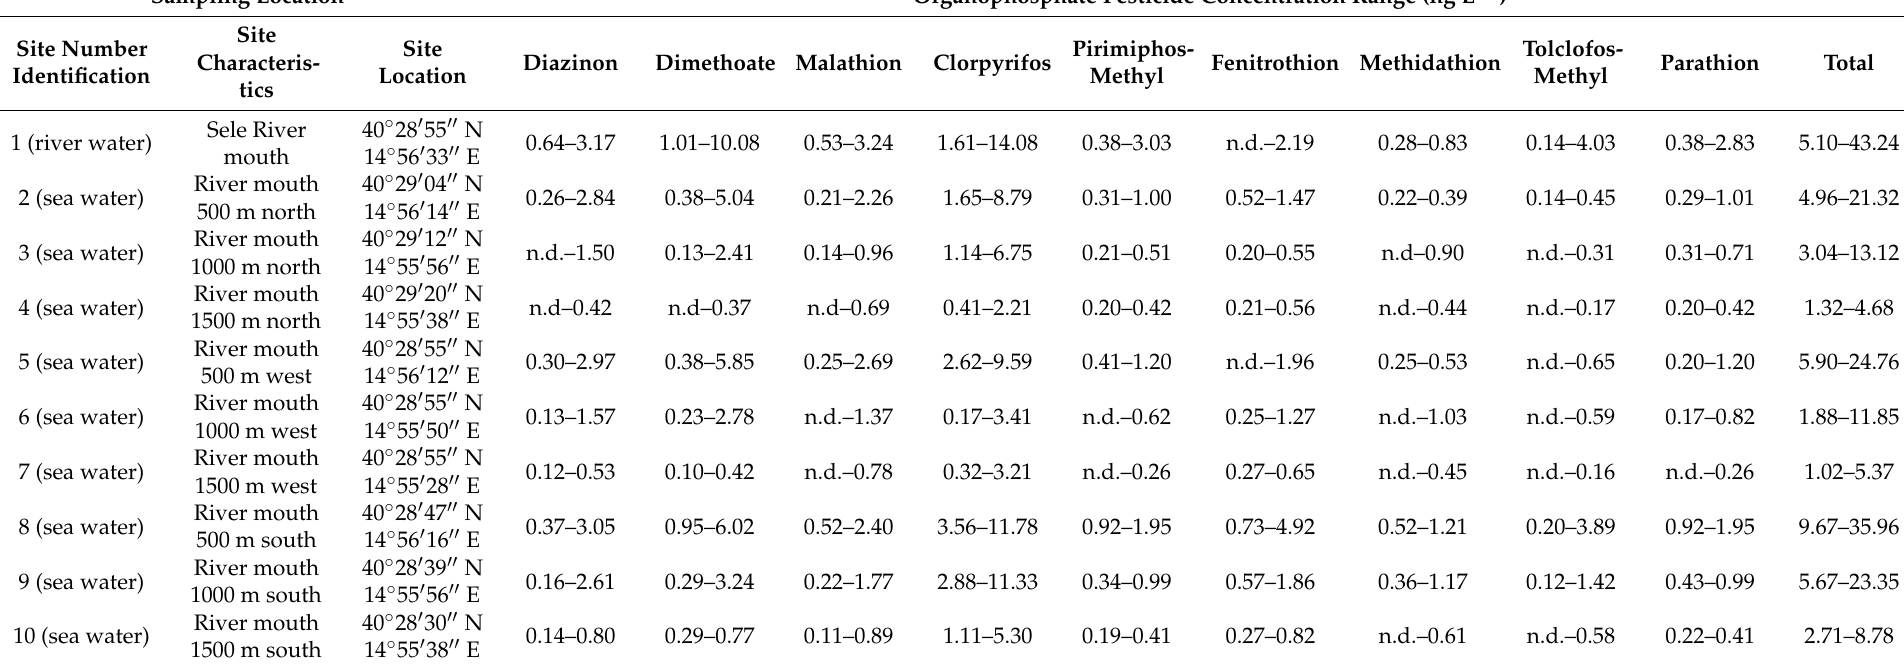
Table 2. Description of the sampling sites and OPP concentration range (ng L − 1 ) detected in the water dissolved phase (WDP) of the Sele River, Southern Italy, during four sampling